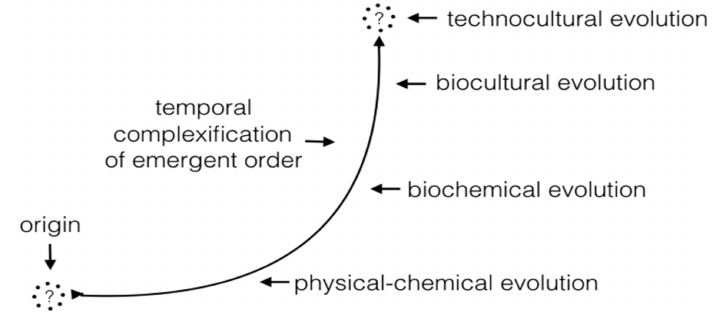
Figure 2. Big historical view of cosmic evolution. Throughout the history of universal evolution (change over time) phenomenon have undergone qualitative transitions enabling the production of new possibility and new order that operate under different basic rules or logics of change. In this schema two basic mysteries connect the beginning (alpha) and end (omega) of cosmic change with the origin of all known matter-energy and spacetime; and with the fate of the most complex known process which gives the signal of a potential future qualitative transition towards new possibility and new